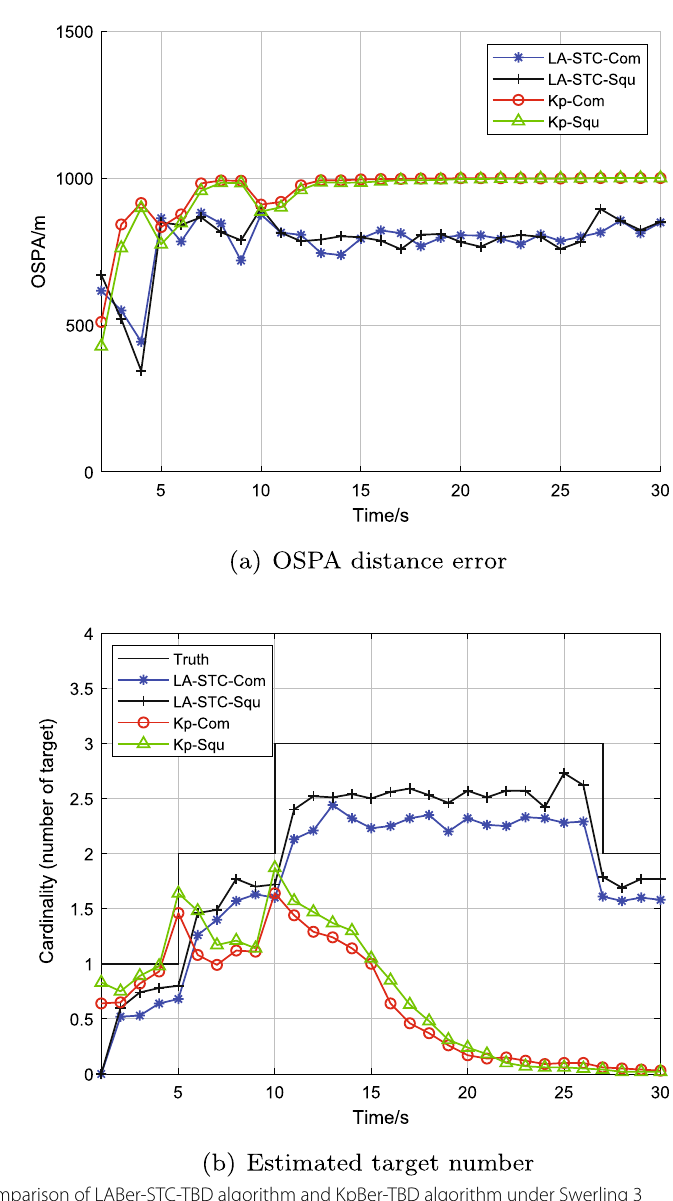
Fig. 8 Comparison of LABer-STC-TBD algorithm and KpBer-TBD algorithm under Swerling